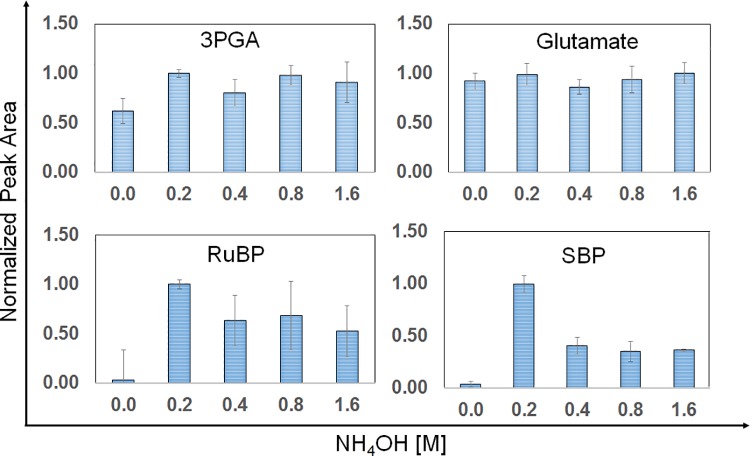
Effect of varying concentrations of NH4OH on extraction of a representative set of metabolites from the strain Synechococcus elongatus PCC 11801.The normalized peak area for the four metabolites (3PGA, Glutamate, RuBP, and SBP) plotted with respect to the NH4OH concentration. Analysis of this data and that for other metabolites of interest led us to choose 0.2 M NH4OH solution for PCC 11801. Such analysis was also extended to other strains and we find addition of 0.4 M NH4OH suited the best for strains PCC 7002 and PCC 7942. Ribulose 1, 5-bisphosphate (RuBP); 3 Phosphoglyceric acid (3-PGA); Sedoheptulose bisphosphate (SBP).